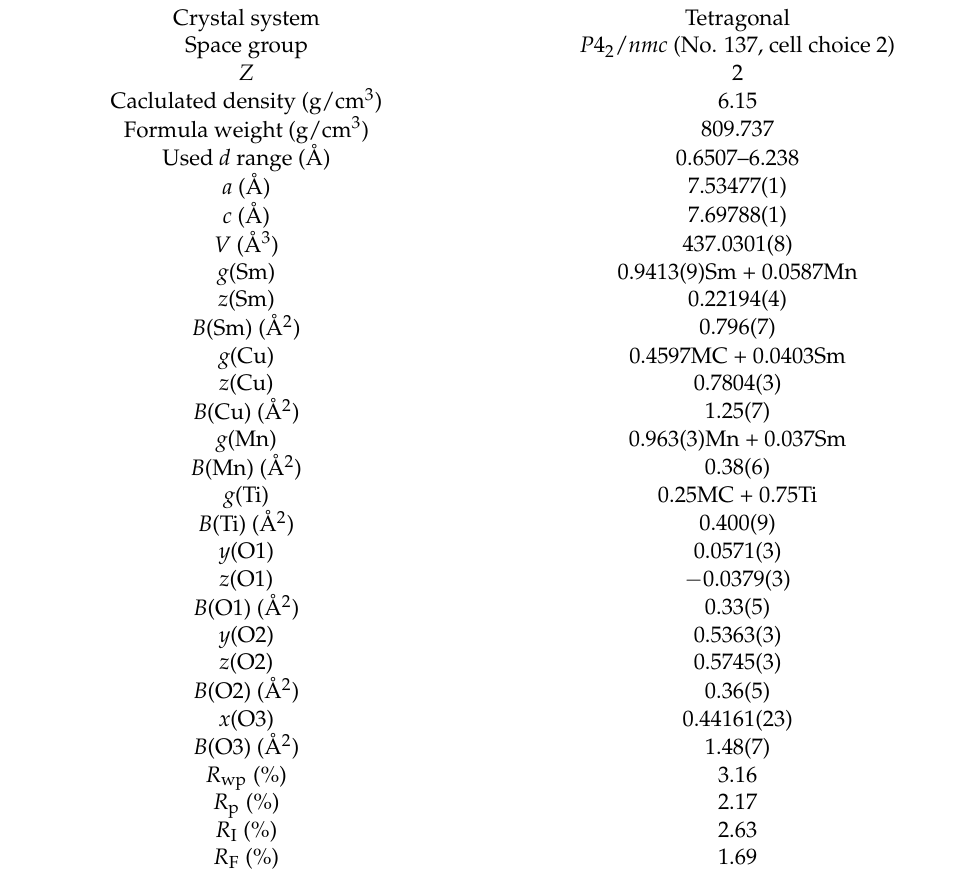
Table 1. Structure parameters of Sm 2 CuMn(MnTi 3 )O 12 from synchrotron powder diffraction data ( λ = 0.65298 Å) at room temperature.